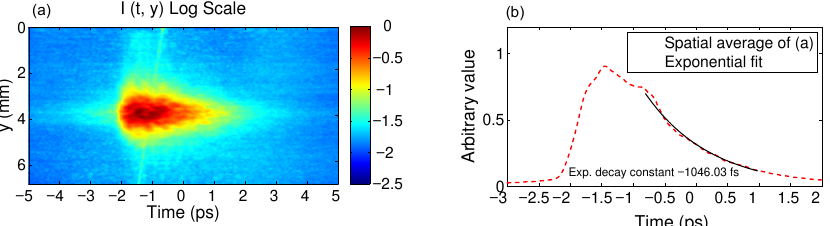
Fig. 2. Position averaged spatio-temporal intensity I ( t ,y ). (a) Ensemble-average of spatio-temporal intensity from forty di ff erent positions of the sample. (b) Spatially integrated ensemble-averaged spatio- temporal intensity of (a). An exponential fit of the intensity decay yields a sample decay time of 1046